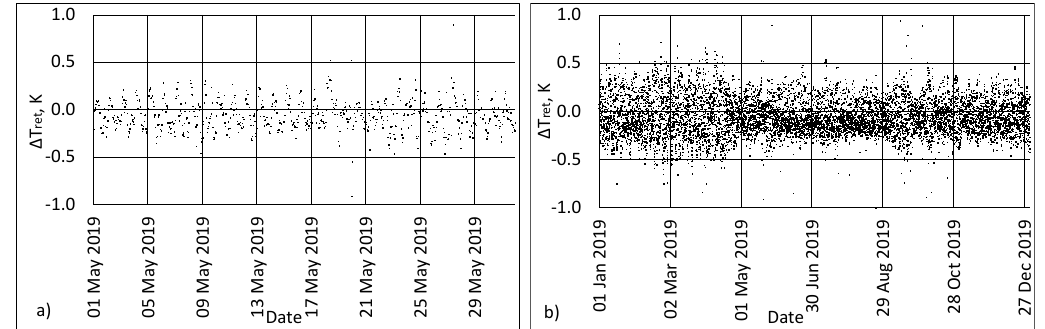
Figure 8. Results of model verification: difference in return temperature value measured and calculated Δ T ret in May 2019 ( a ) and the year of 2019 ( b ).